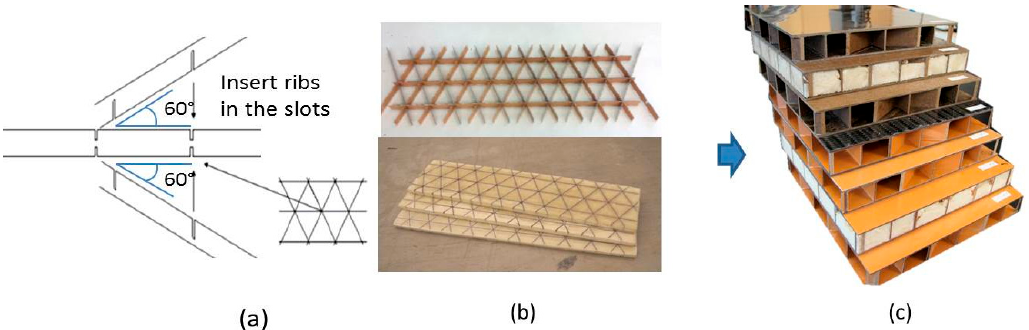
Figure 1. Various designs and configurations for tri-axial engineered bio-composite panels, ( a ) interlocked tri-axial structure; ( b ) structural core without foam or with foam and ( c ) tri-axial composite panels with various configurations.